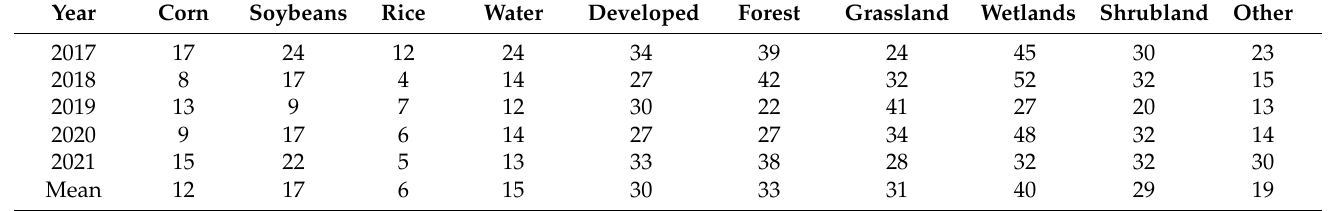
Table 4. The percentage of each type of sample removed by DNN-based ensemble learning. × 100% ) . ( Count CDL − Count EL Count CDL